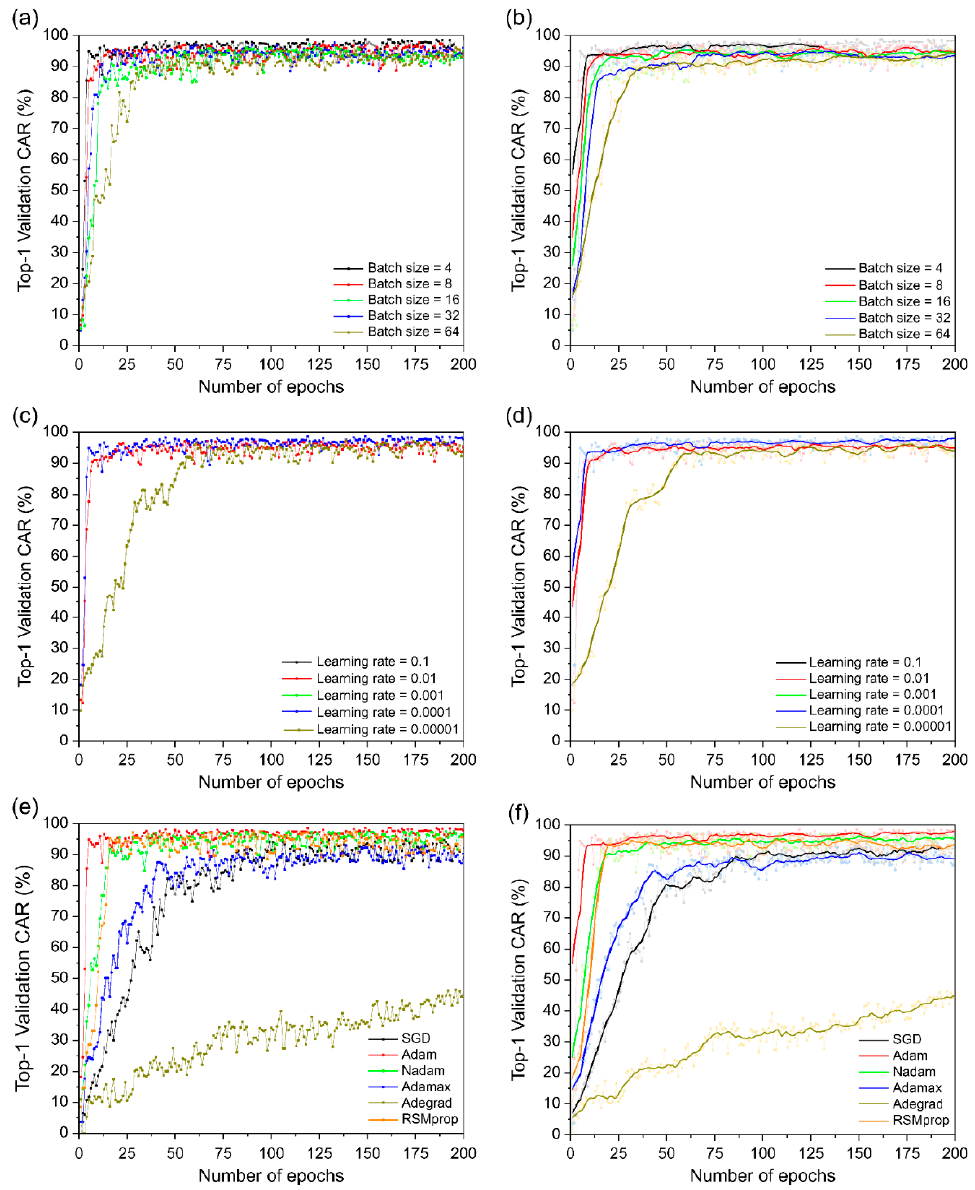
Figure 11. Training steps for character accuracy rate (CAR) comparing different batch sizes, learning rates, and optimizers: ( a ) Different batch sizes; ( b ) different batch sizes using moving average; ( c ) different learning rates; ( d ) different learning rates using moving average; ( e ) different optimizers; ( f ) different optimizers using moving average. Table 4. Performance of different batch sizes, learning rates, and optimizers on the collected